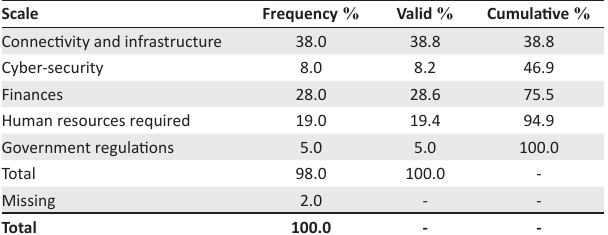
TABLE 3: Perceived impact of digitalisation ( n = 100).